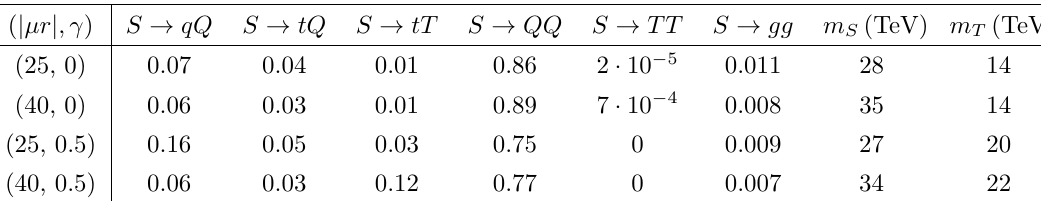
2 -odd scalar, S , for all cases 10 TeV for all (cid:25)